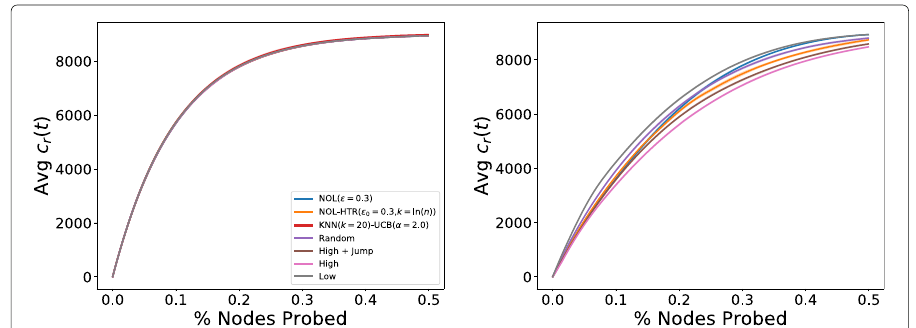
Fig. 7 Results on ER and regular networks. All methods perform indistinguishably in ER networks because the degree distribution is homogeneous and there is little clustering or modular structure. Querying the lowest degree node is approximately optimal in the regular network, since the lowest degree node has the maximum missing connections